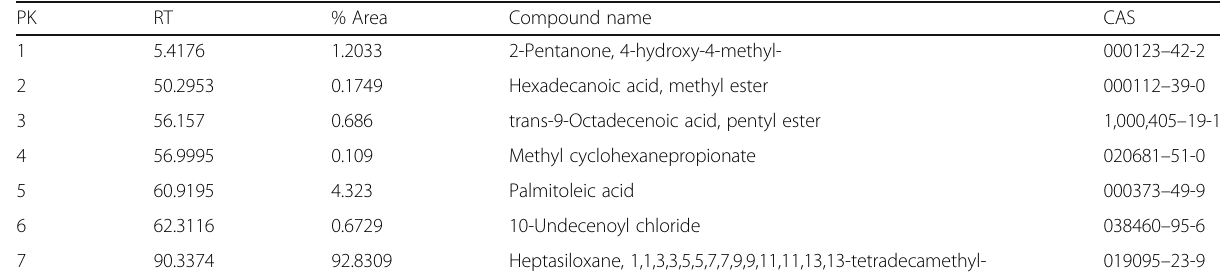
Table 6 GCMS Profiling of the Ethanol Extract of Feretia apodanthera PK RT %